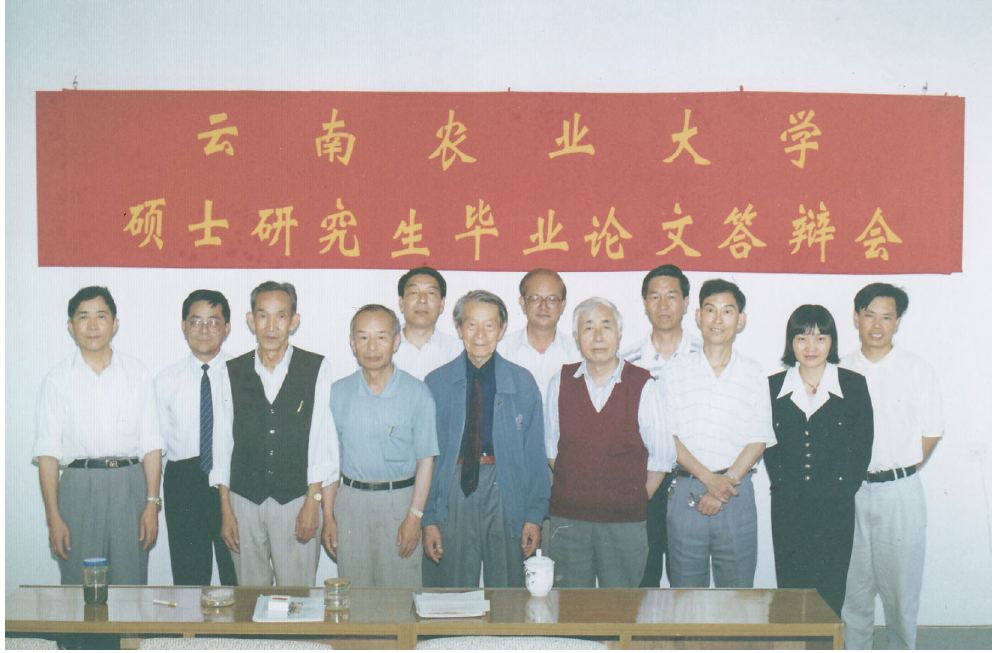
Figure 4. Prof. Duan (The third from the left in the fi rst row) in his student ’ s master ’ s thesis defence.